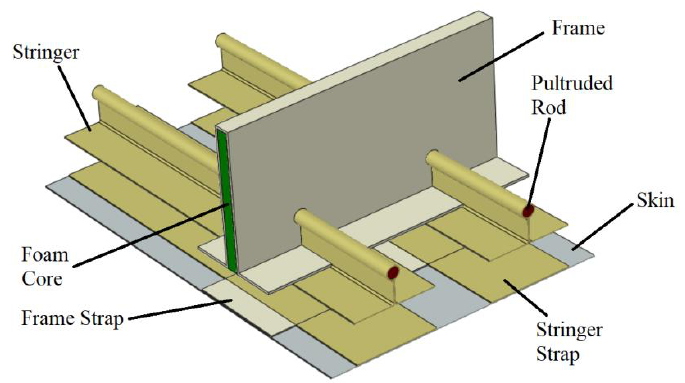
Figure 1. Structural components of the PRSEUS concept.